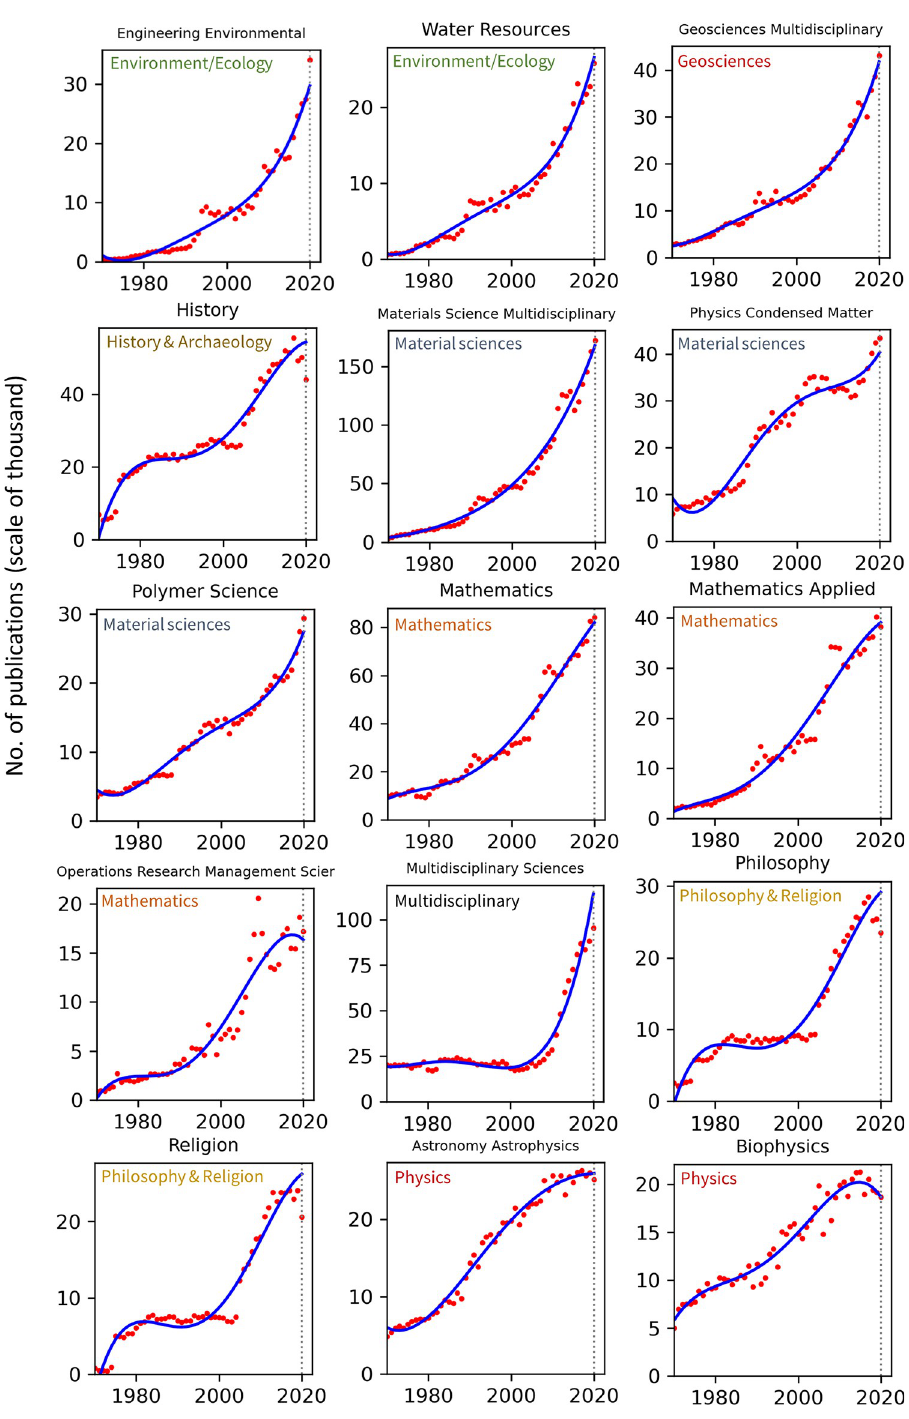
Fig 7. Temporal trends of research productivity in various scientific disciplines (part